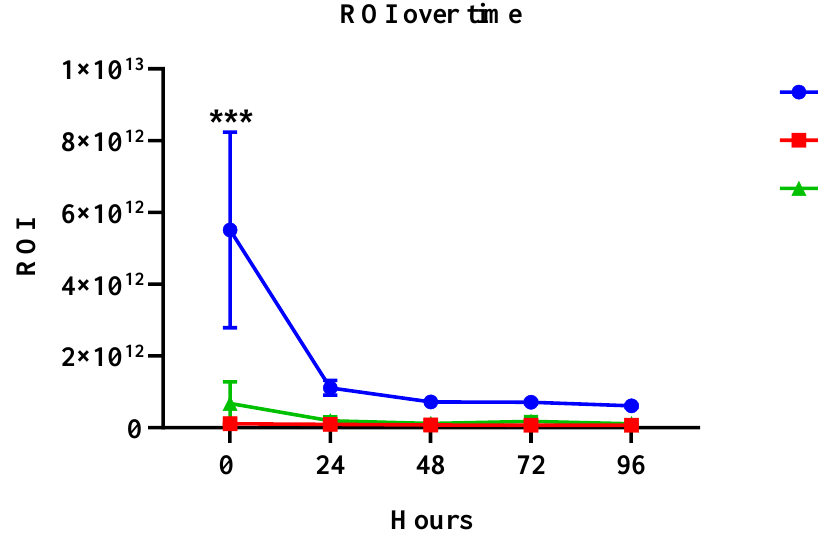
and (NP) inoculated with the fluorescent nanoparticles. inoculated with the fluorescent nanoparticles.